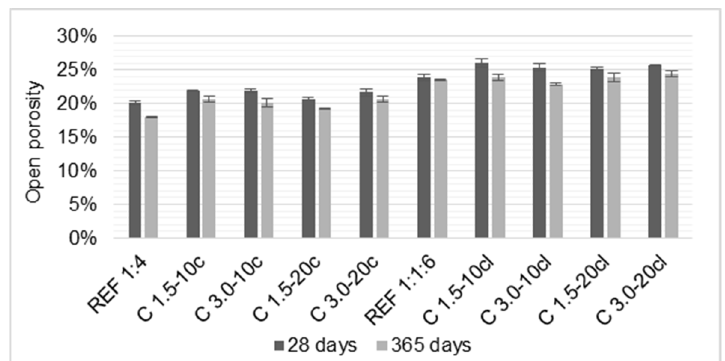
Figure 12. Open porosity test results of the mortars tested.